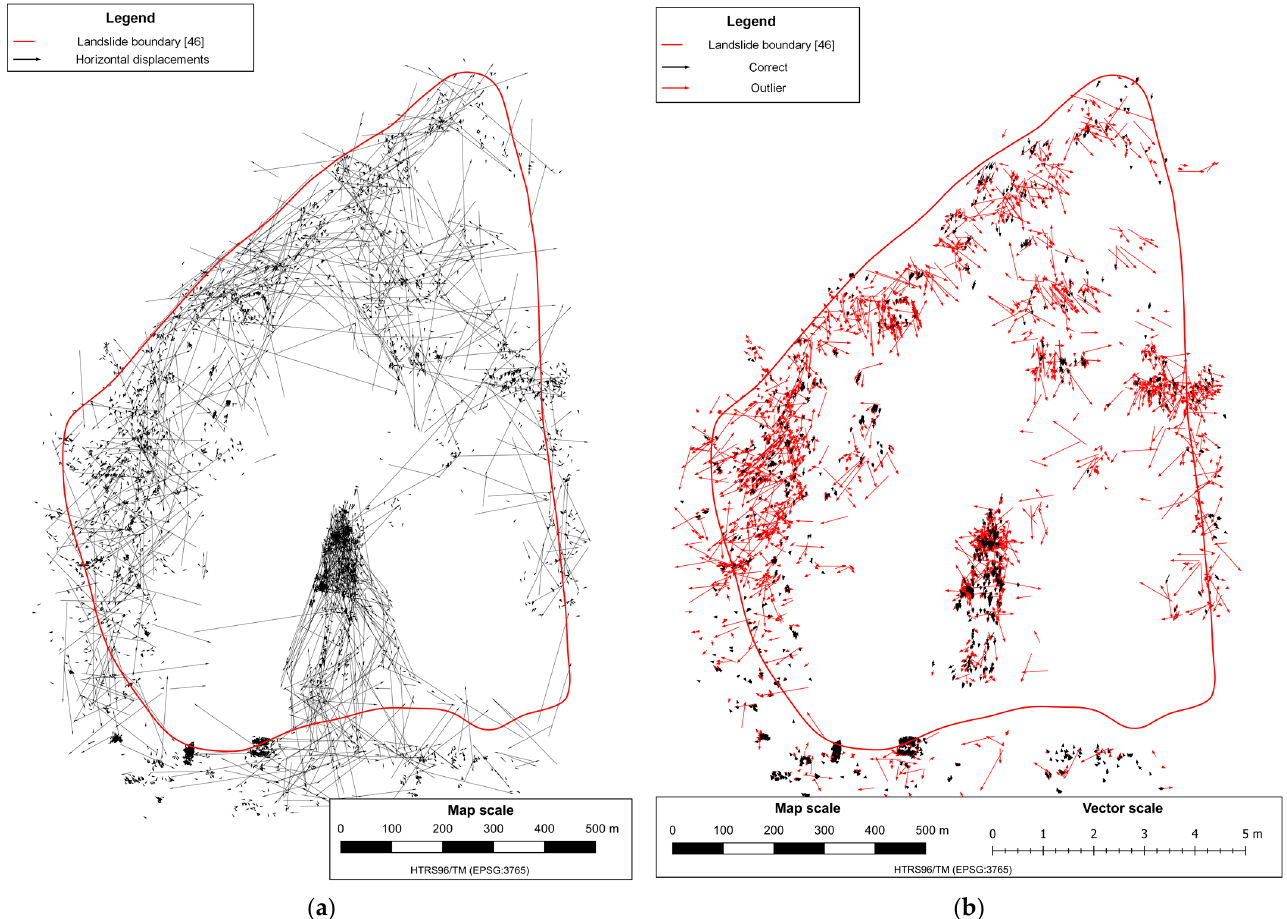
Figure 14. Remaining horizontal displacement vectors after the filtering ( a ), and final displacements vectors with highlighted outliers ( b ).